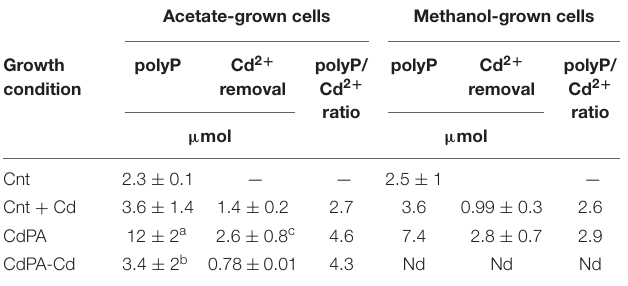
TABLE 1 | PolyP content and cadmium removal in Methanosarcina acetivorans. Acetate-grown cells Methanol-grown cells